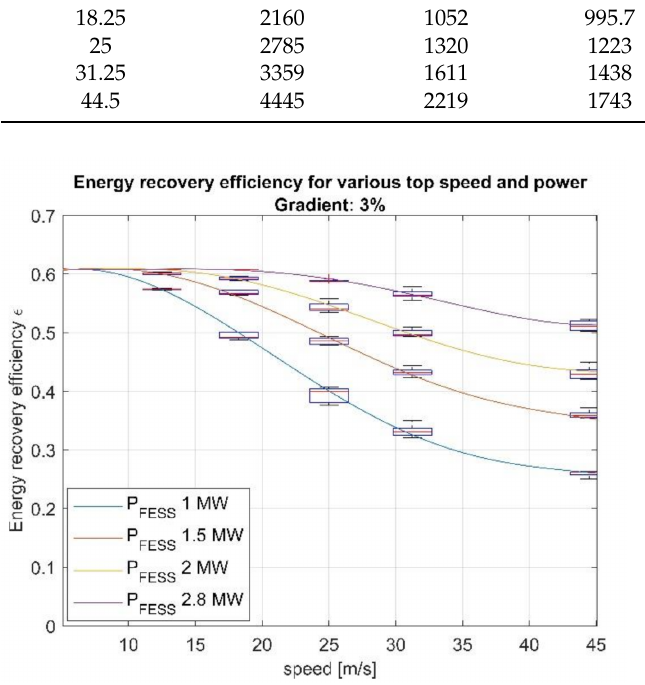
Figure 10. Three percent gradient energy recovery efficiency for multiple top speeds and FESS powers.